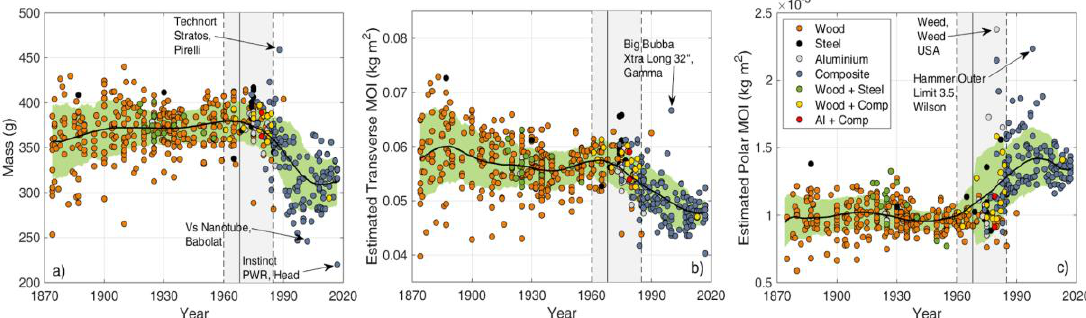
Figure 5. Change in geometry of tennis rackets from 1870s; ( a ) estimated head area; ( b ) string bed density and ( c ) the ratio between frame depth and thickness.